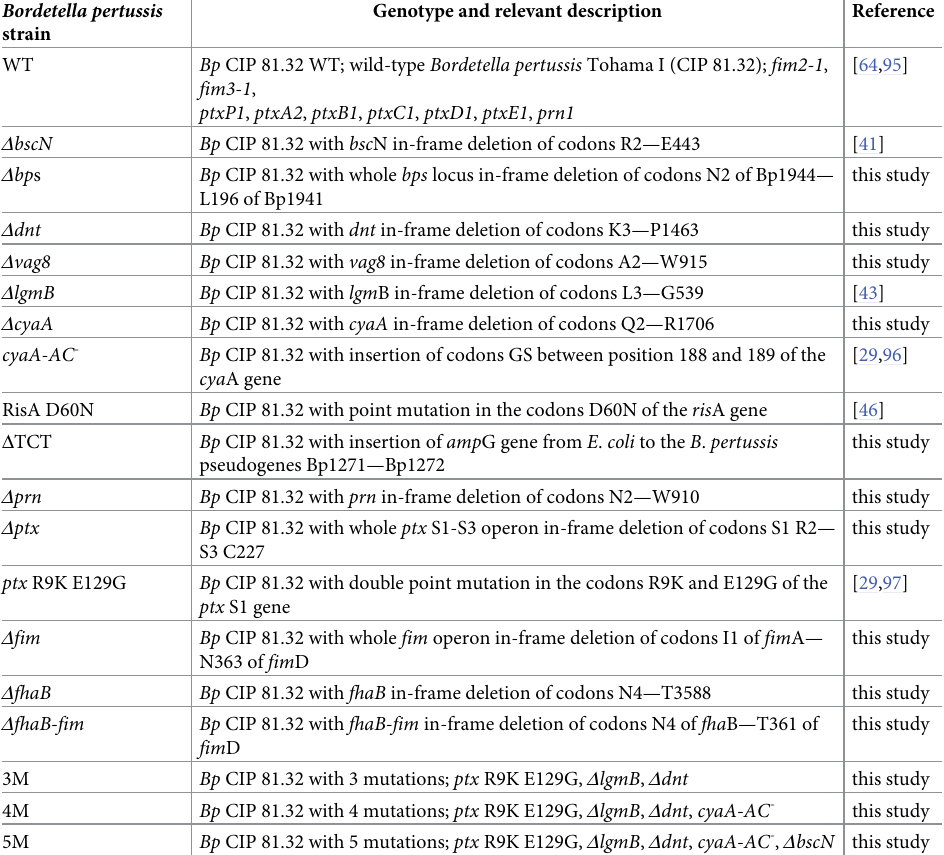
Table 1. List of bacterial strains used in this study. Bacterial strain name, genotype description and reference are indicated. Bordetella pertussis